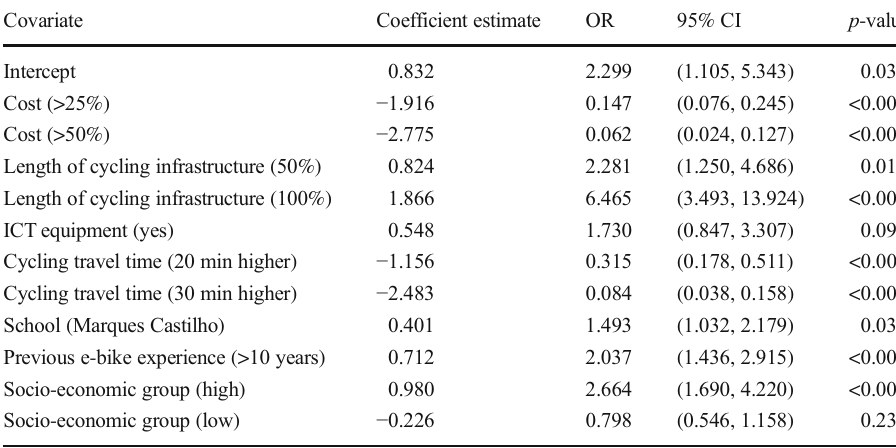
Covariate Coefficient